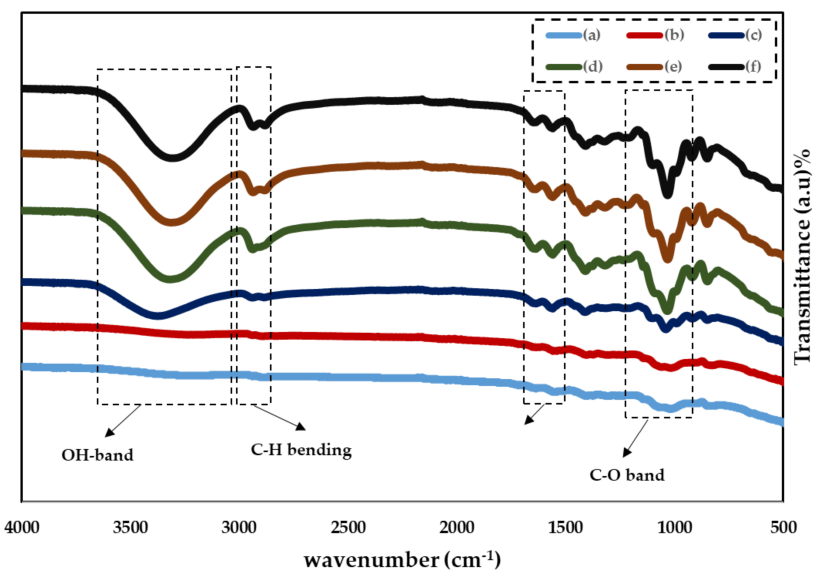
Figure 2. ( e ) CSPVNG44 and ( f ) CSPVNG55. Table 2. Assignments of FTIR bands for PVA:CS: NaBr:GL solid PEs.